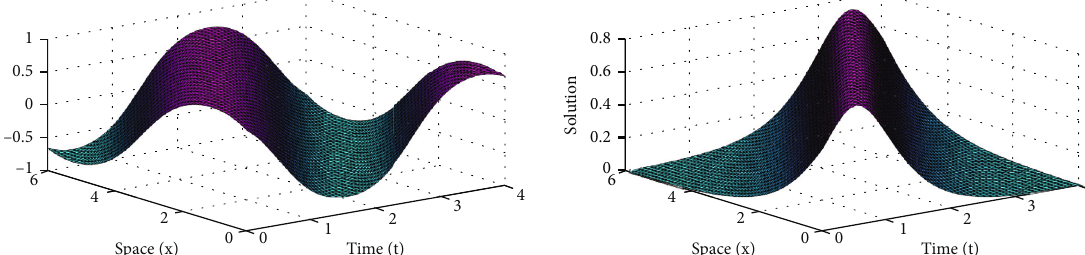
Figure 1: 3D diagram of Equations (25) and (45) with σ = 0 :